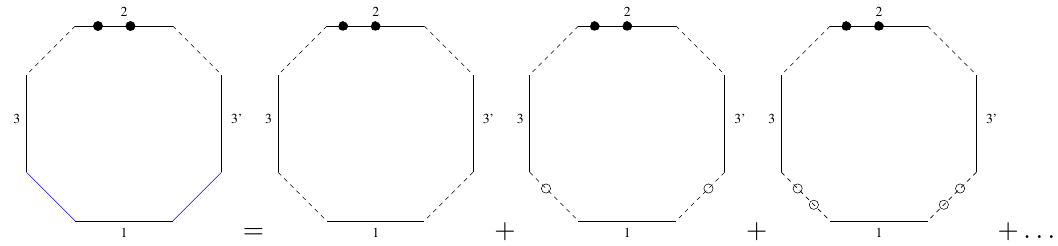
Figure 3 . Summing up octagons to get the DSFT vertex. The blue edges are glued together by summing up for all multi-particle mirror states, represented by empty circles. Physical particles are represented by solid